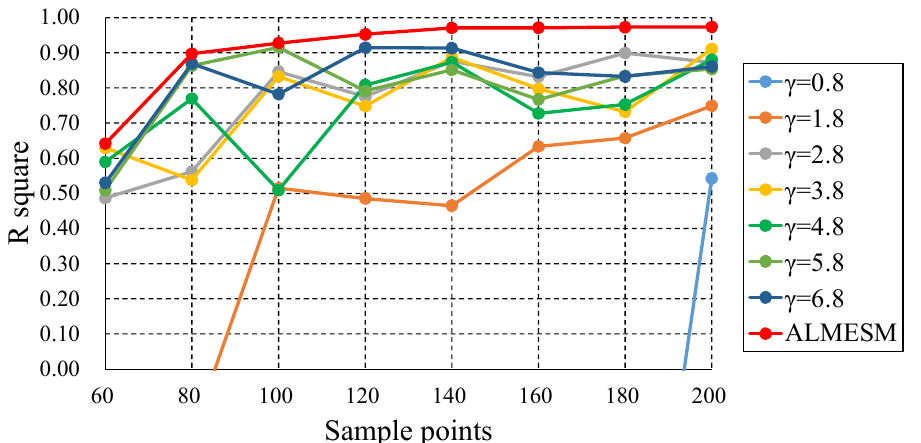
Figure 6. R-squared comparison of ALMESM, and the original LME approximation with different globally unified γ under different number of sample points in the 6-D function.